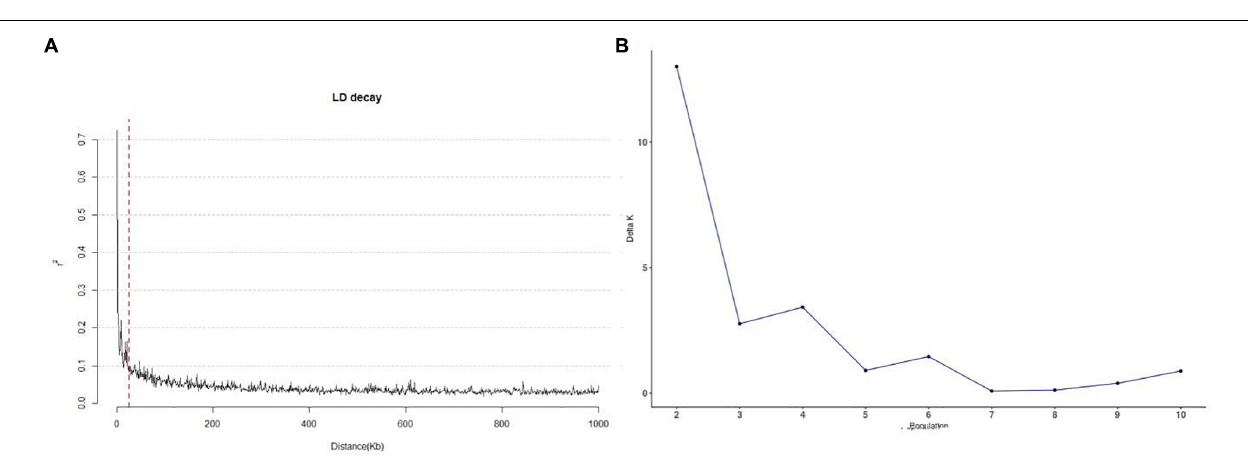
FIGURE 2 | Linkage disequilibrium decay and the population structure of 245 sorghum accessions. (A) Genome distribution of r 2 -values estimated from 245 sorghum accessions. The red dotted line represents 25 kb. (B) Calculation of (cid:77) K based on the value of Ln P(D) between successive K